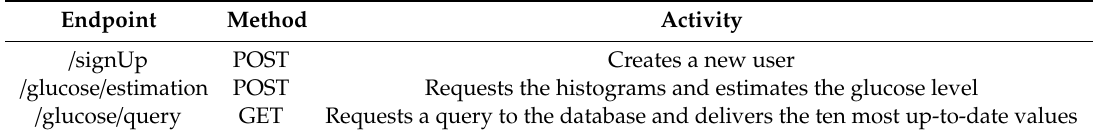
Table 1. API structure for the proposed